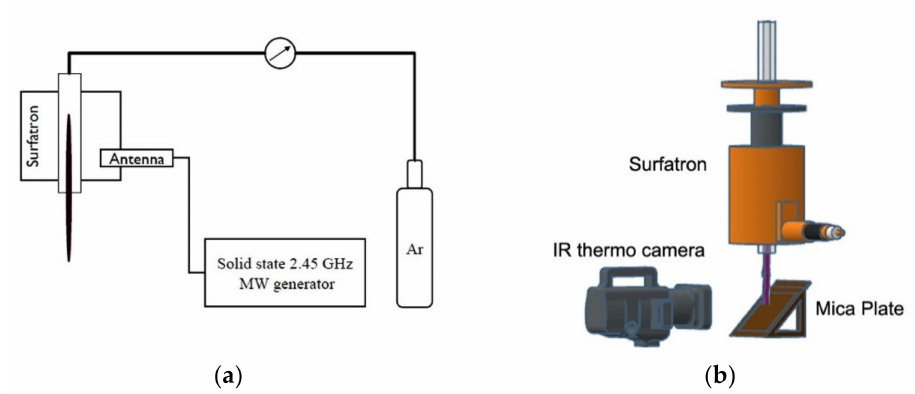
Figure 2. Experimental set-up: ( a ) surface-wave sustained argon plasma torch; ( b ) Mica Plate and infrared thermo camera